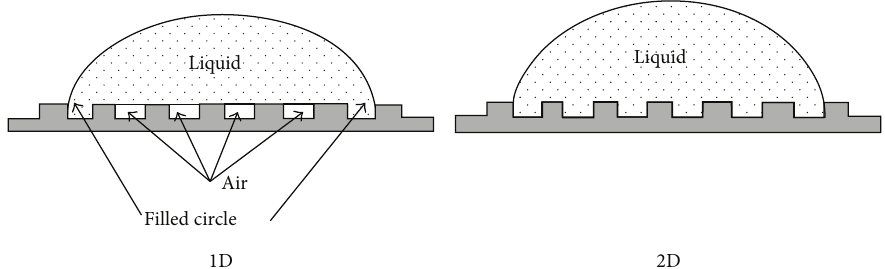
Figure 6: Scheme illustrating 1D and 2D scenarios of wetting transitions